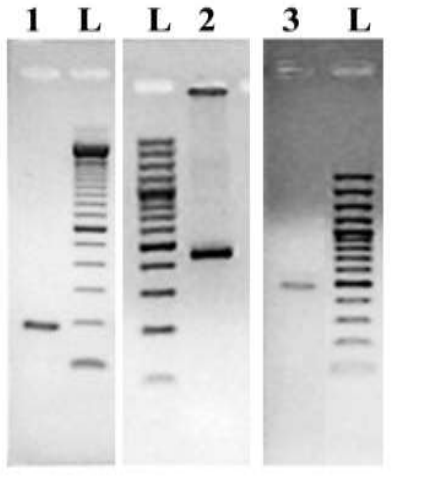
Figure 4. Electrophoretic separation of the PCR products obtained from amplification of Amphora coffeaeformis chromosomal DNA with primer pairs: (1) specific for small-subunit rRNA; (2) UniE-F and UniE-R, specific for a portion of the gene coding for the diatom elongation factor eEF1-a and (3) UniS-F 1 and UniS-R 1 , specific for a portion of the gene coding for the diatom silicic acid transporter ( SIT ). The DNA fragment shown in lane 3 represents the amplicon after purification by agarose gel extraction. Lane L contains the 100 bp DNA ladder